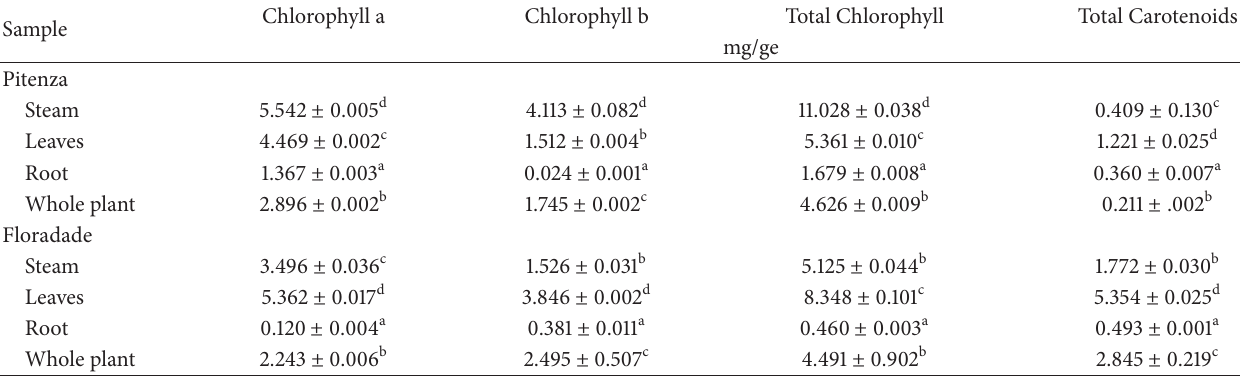
Table 2: Total chlorophyll, total carotenoids, and chlorophyll a and chlorophyll b contents in tomato plant